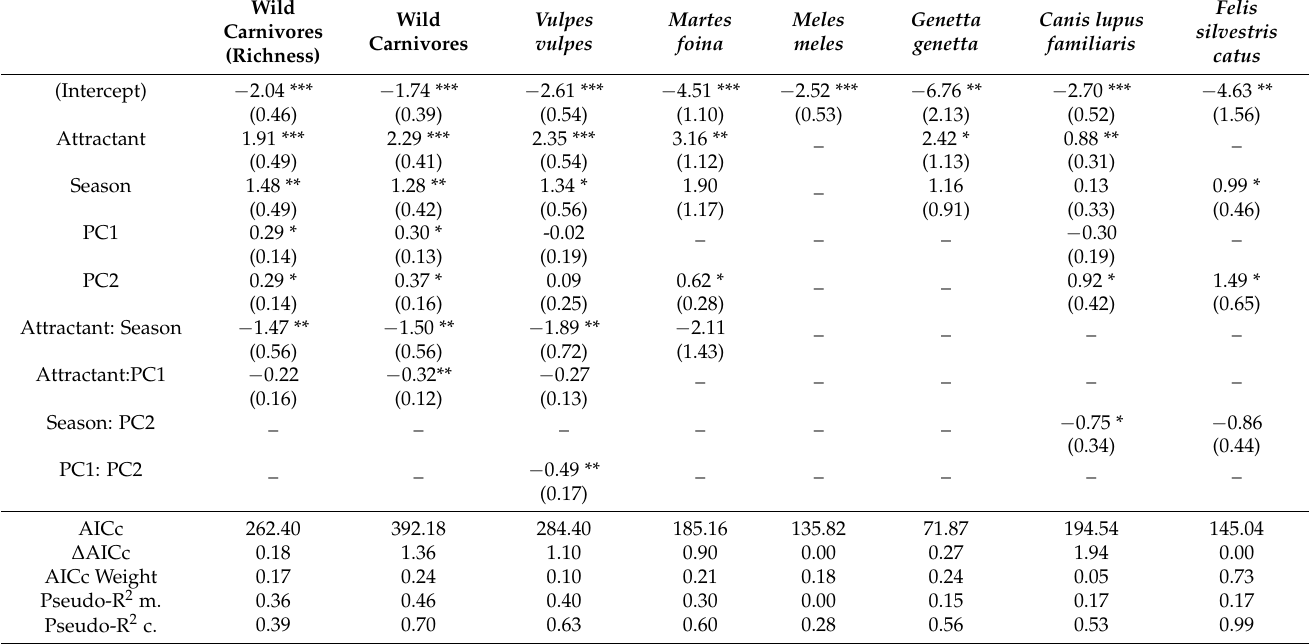
Table 1. Generalised linear mixed models (GLMM) with Poisson error distribution selected for each response variable (they are simple counts, contacts, except for the first one, richness). Transect and camera position were applied as nested random factors in all models. The selected model corresponds to the one with the highest conditional pseudo-R 2 (Pseudo- R 2 c.) among the models with ∆ AICc < 2. Four explanatory variables: Attractant (factor with two levels: presence, absence—taken as reference), Season (factor with two levels: winter, summer—taken as reference), the two principal components PC1 and PC2 (continuous covariates) summarising vegetation structure, and their interactions. Model β coefficients and, in brackets, their standard error. In all cases, n = 127. The same models with binomial and negative binomial error distribution showed similar results (not shown).